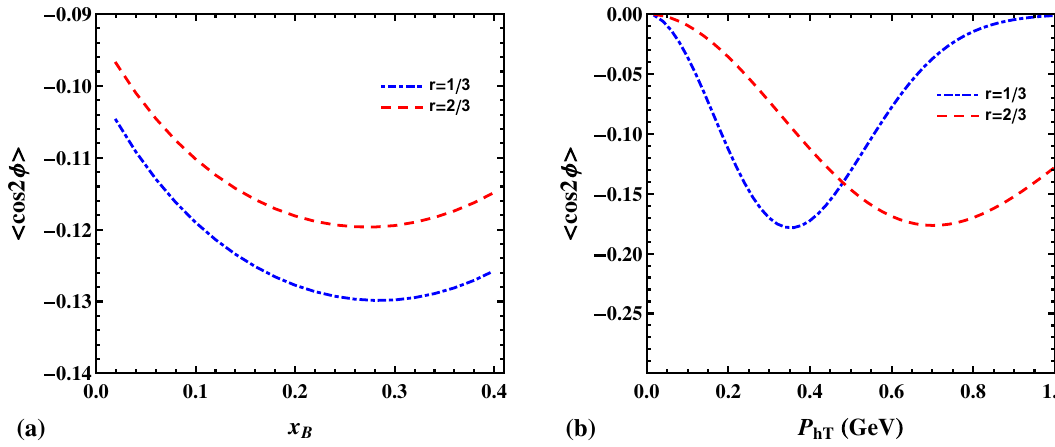
√ s = 7 . 2 GeV (HERMES).